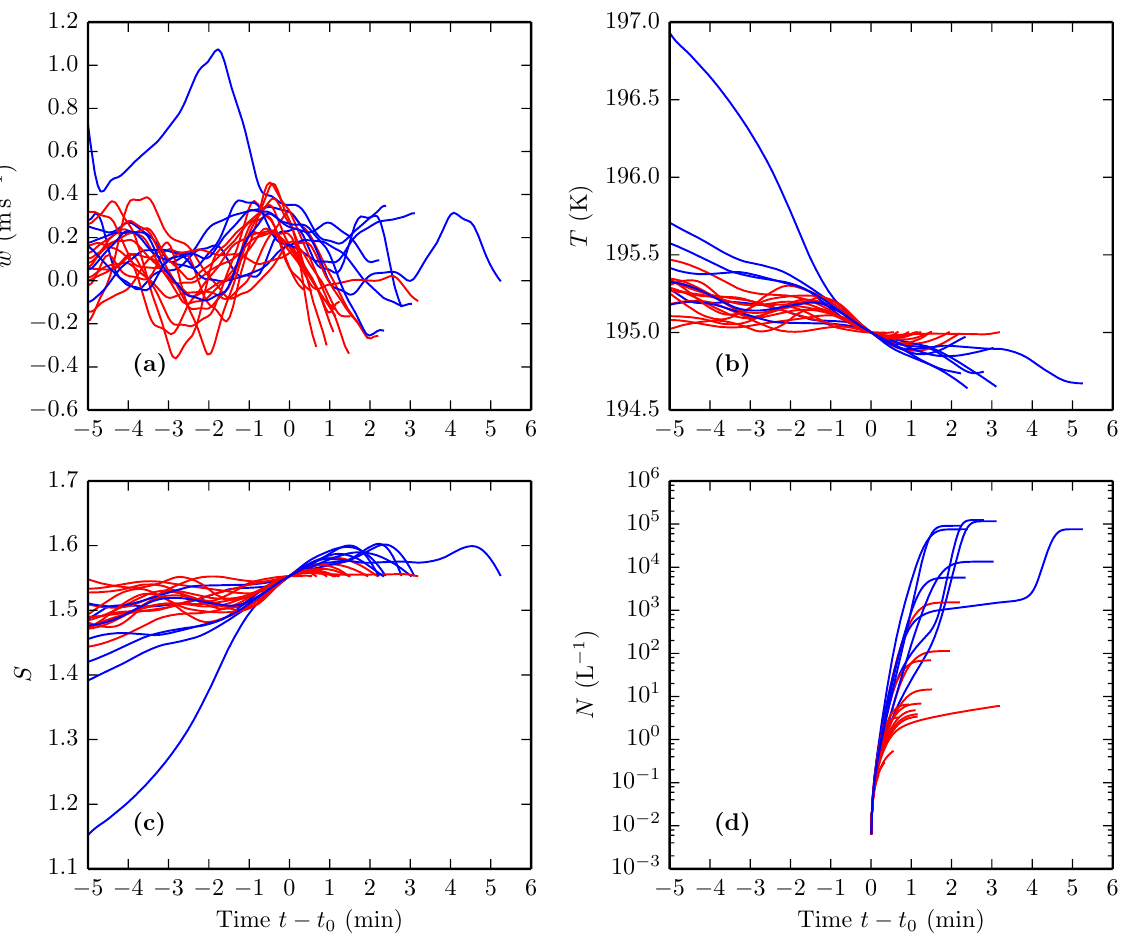
Figure 6. Evolution of vertical velocity (a) , temperature (b) , saturation ratio (c) , and INC (d) in the period immediately before and during representative nucleation events forced by the temperature perturbations derived from the balloon data. The plots are shown for an extended period of time before nucleation begins at t 0 to illustrate the background condition leading to nucleation. Blue curves show vapour-limit events and red curves show temperature-limit